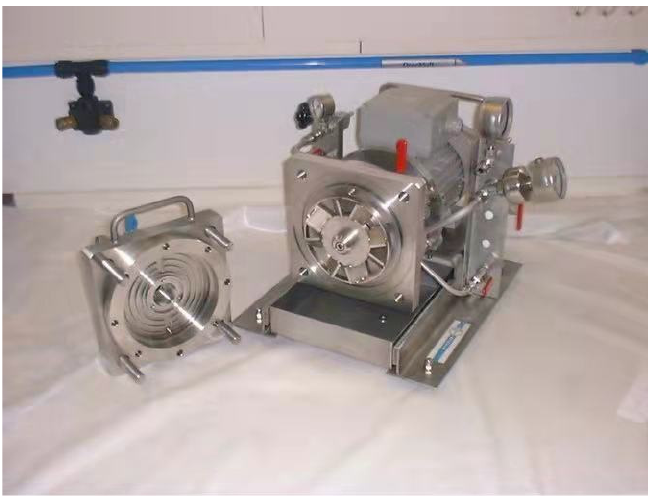
Figure 13. The dynamic cross-flow experimental setup, showing the vane.